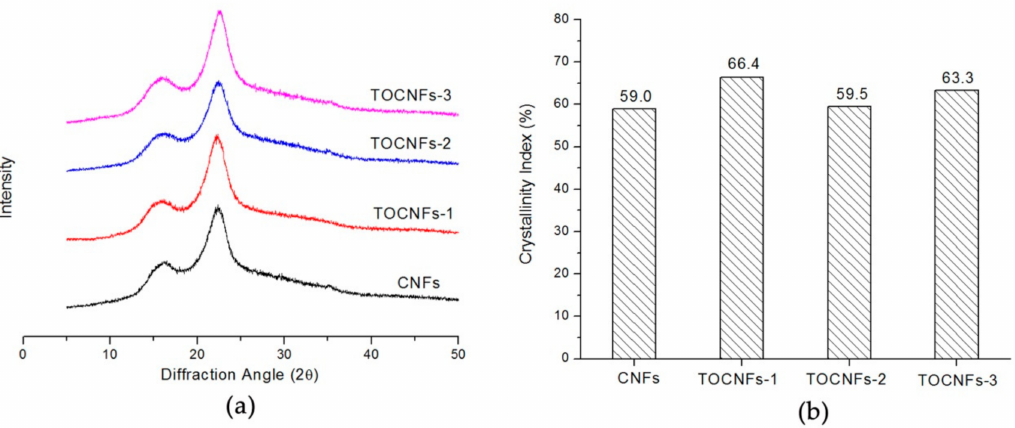
Figure 3. ( a ) X-ray diffraction and ( b ) crystallinity index of CNFs and TEMPO-oxidized CNFs of different carboxylate